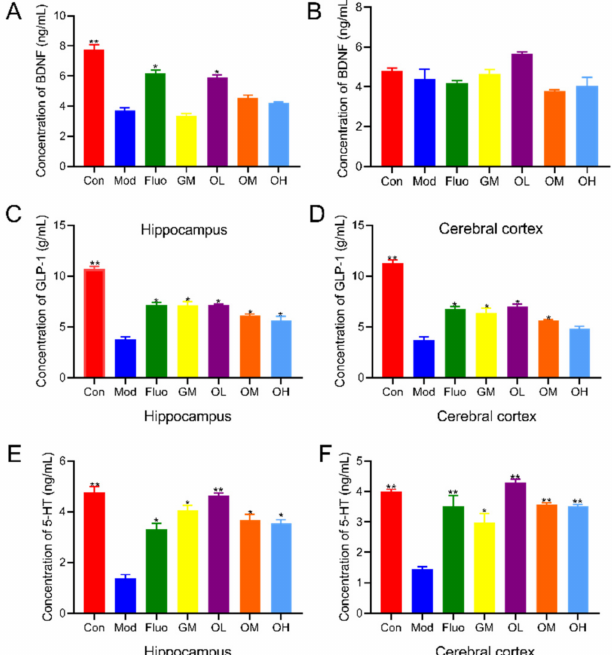
Figure 3. Jasmine tea ameliorated neurotransmitters in the hippocampus and cerebral cortex in depressive rats. ( A ). Concentration of BDNF in the hippocampus; ( B ). concentration of BDNF in the cerebral cortex; ( C ). concentration of GLP-1 in the hippocampus; ( D ). concentration of GLP-1 in the cerebral cortex; ( E ). concentration of 5-HT in the hippocampus; ( F ). concentration of 5-HT in the cerebral cortex. Con, control group; Mod, CUMS group; Fluo, CUMS rats treated with fluoxetine; GM, CUMS rats treated with green tea dhool at a middle dose; OL, CUMS rats treated with jasmine tea at a low dose; OM, CUMS rats treated with jasmine tea at a middle dose; OH, CUMS rats treated with jasmine tea at a high dose. (* p < 0.05 vs. Mod, ** p < 0.01 vs.